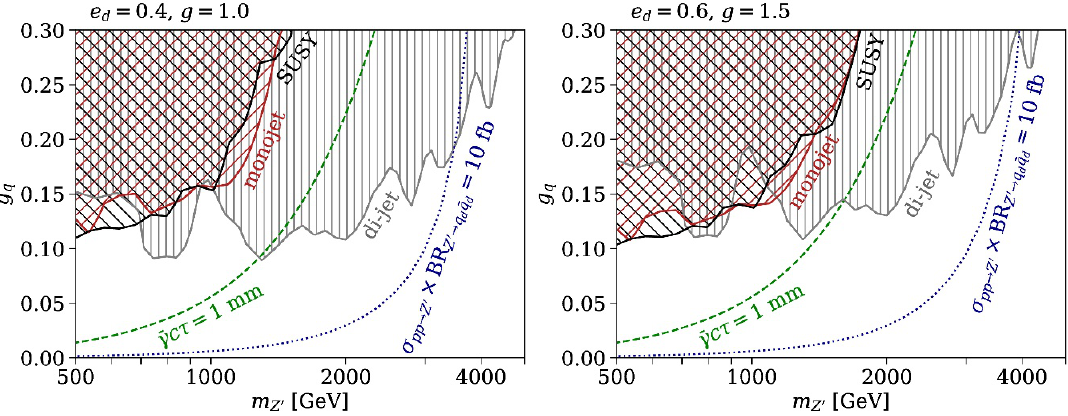
Figure 5 . Summary of existing LHC constraints on the dark sector model considered in this work. Above the green dashed line it is a good approximation to treat (cid:26) 0 decays as prompt, whereas below the line one expects displaced